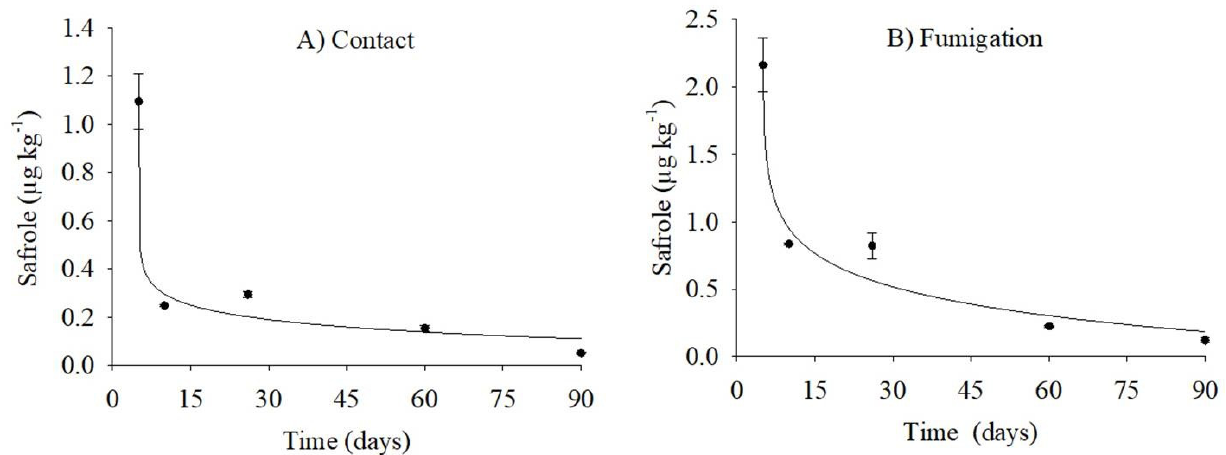
Figure 5. Persistence of safrole residue in cowpea beans treated with Piper hispidinervum essential oil, either by contact ( A ) or fumigation ( B ), throughout storage. Sample mass: 5.0 g; extraction: 60 °C for 10 min ( n = 3).